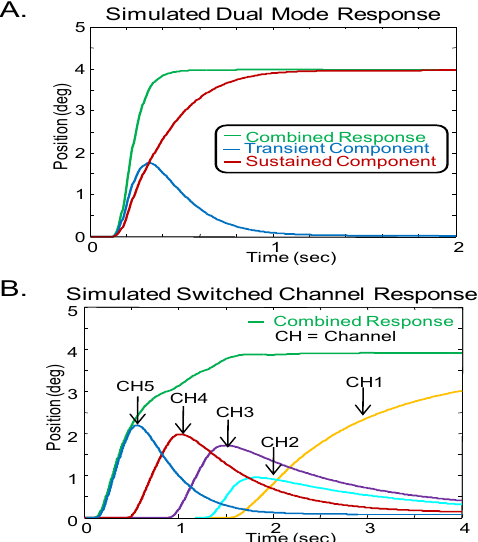
Simulated Dual Mode Response A.